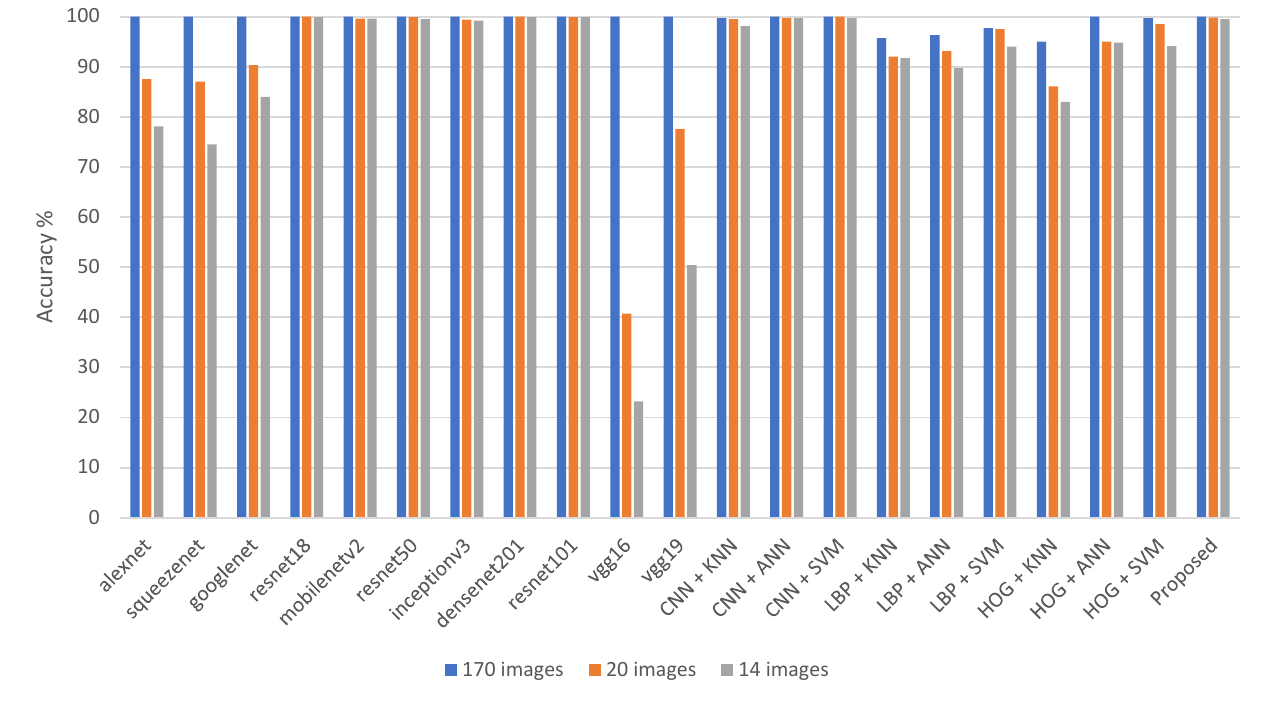
Figure 13. Impact of reducing the size of the training dataset.